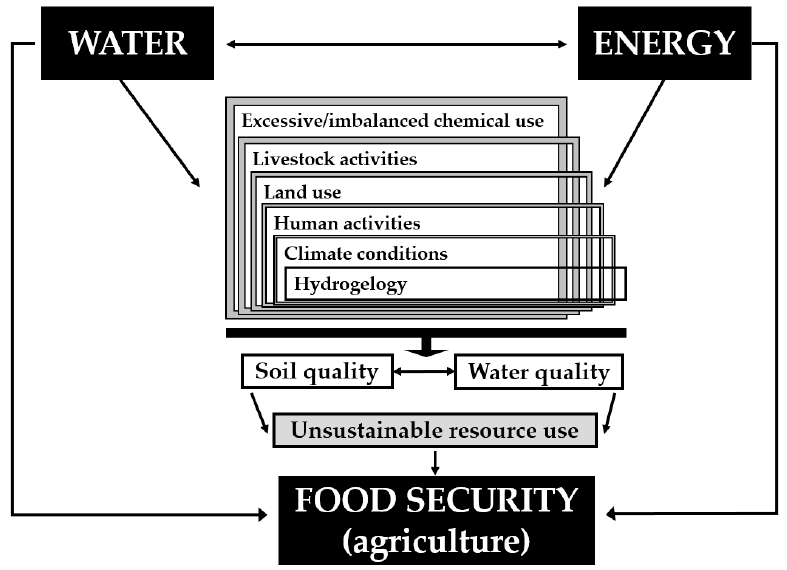
Figure 4. Understanding the nexus: a trans-disciplinary